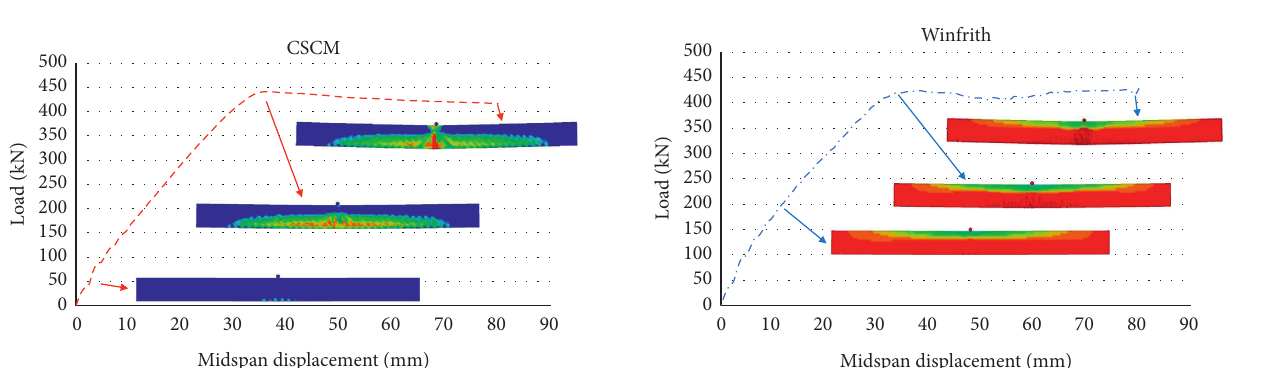
Figure 17: Crack development at different loading stages using Winfrith concrete material